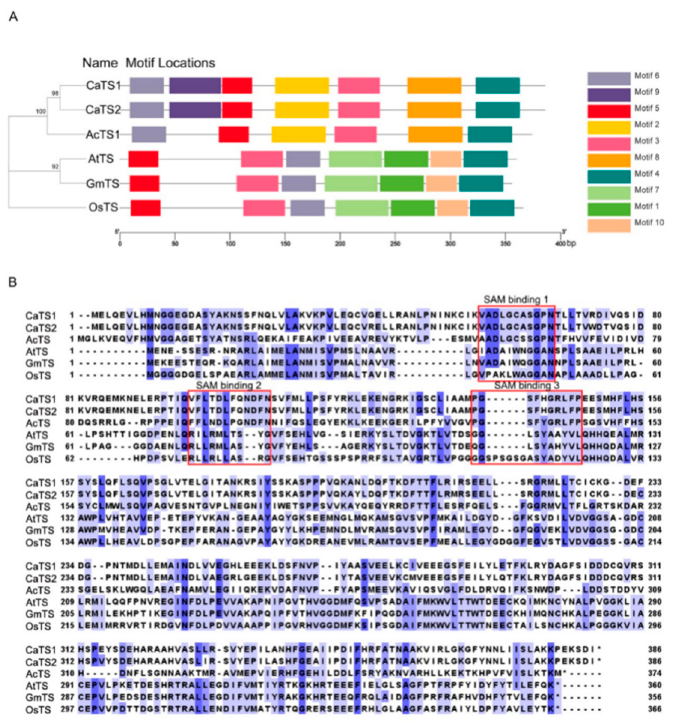
Figure 3. Sequence analysis of trigonelline synthases from different plant species. ( A ) Phylogenetic tree and conserved motifs of AcTS, CaTS1, CaTS2, AtTS, GmTS and OsTS. Different motifs are represented by different boxes. The location of each motif can be estimated using the scale at the bot- tom. ( B ) Alignment of amino acid sequences of AcTS, CaTS1, CaTS2, AtTS, GmTS and OsTS. Three proposed SAM regions are shown in the open boxes. AcTS: Areca catechu trigonelline synthase; AtTS: Arabidopsis thaliana trigonelline synthase; OsTS: Oryza sativa trigonelline synthase; CaTS: Coffea ara- bica trigonelline synthase; GmTS: Glycine max trigonelline synthase.